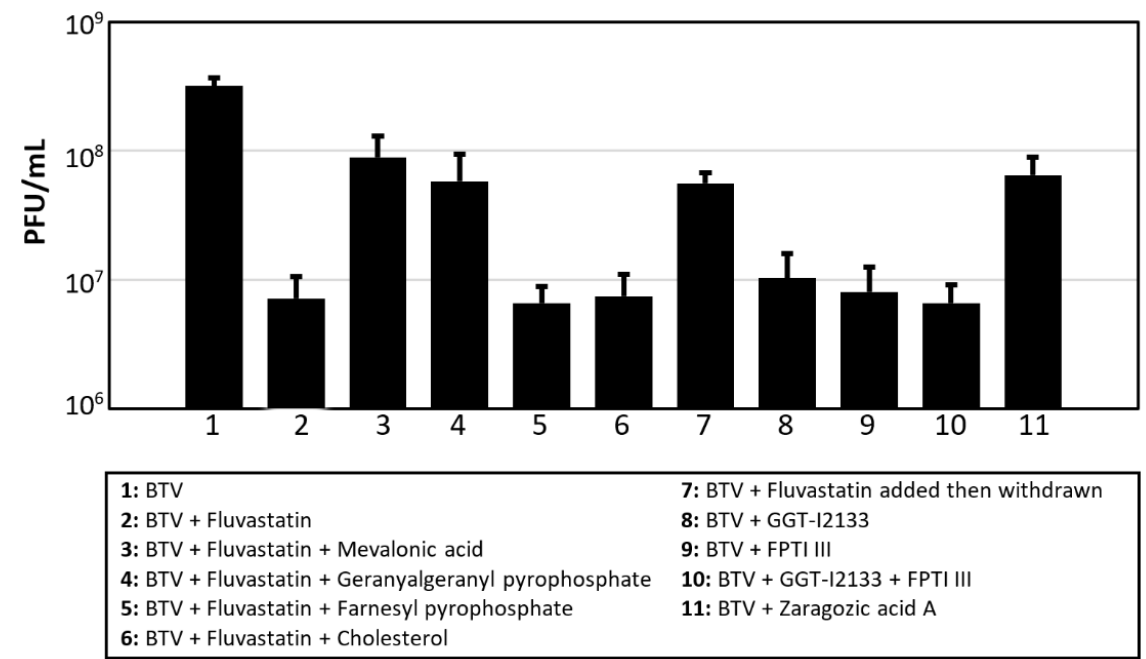
Figure 6. Effects of fluvastatin, mevalonate pathway-components and inhibitors on BTV replication in BSR cells. BTV-8 titres (PFU/mL) generated in BTV-8-infected BSR cells, treated with: fluvastatin; inhibitors of geranyl-geranylation (geranyl-geranyl transferase inhibitor GGTI-2133, or farnesyl pyrophosphate transferase inhibitor FTPIII); or inhibitors of squalene synthase (zaragozic acid A). Some cells were treated with fluvastatin then supplemented with components of the mevalonate pathway (mevalonic acid, geranylgeranyl pyrophosphate, farnesyl pyrophosphate or cholesterol), to inhibit, or in attempts to restore, virus replication in fluvastatin-treated cells. These results are representative of 4 independent experiments. Error bars with standard deviations are shown.